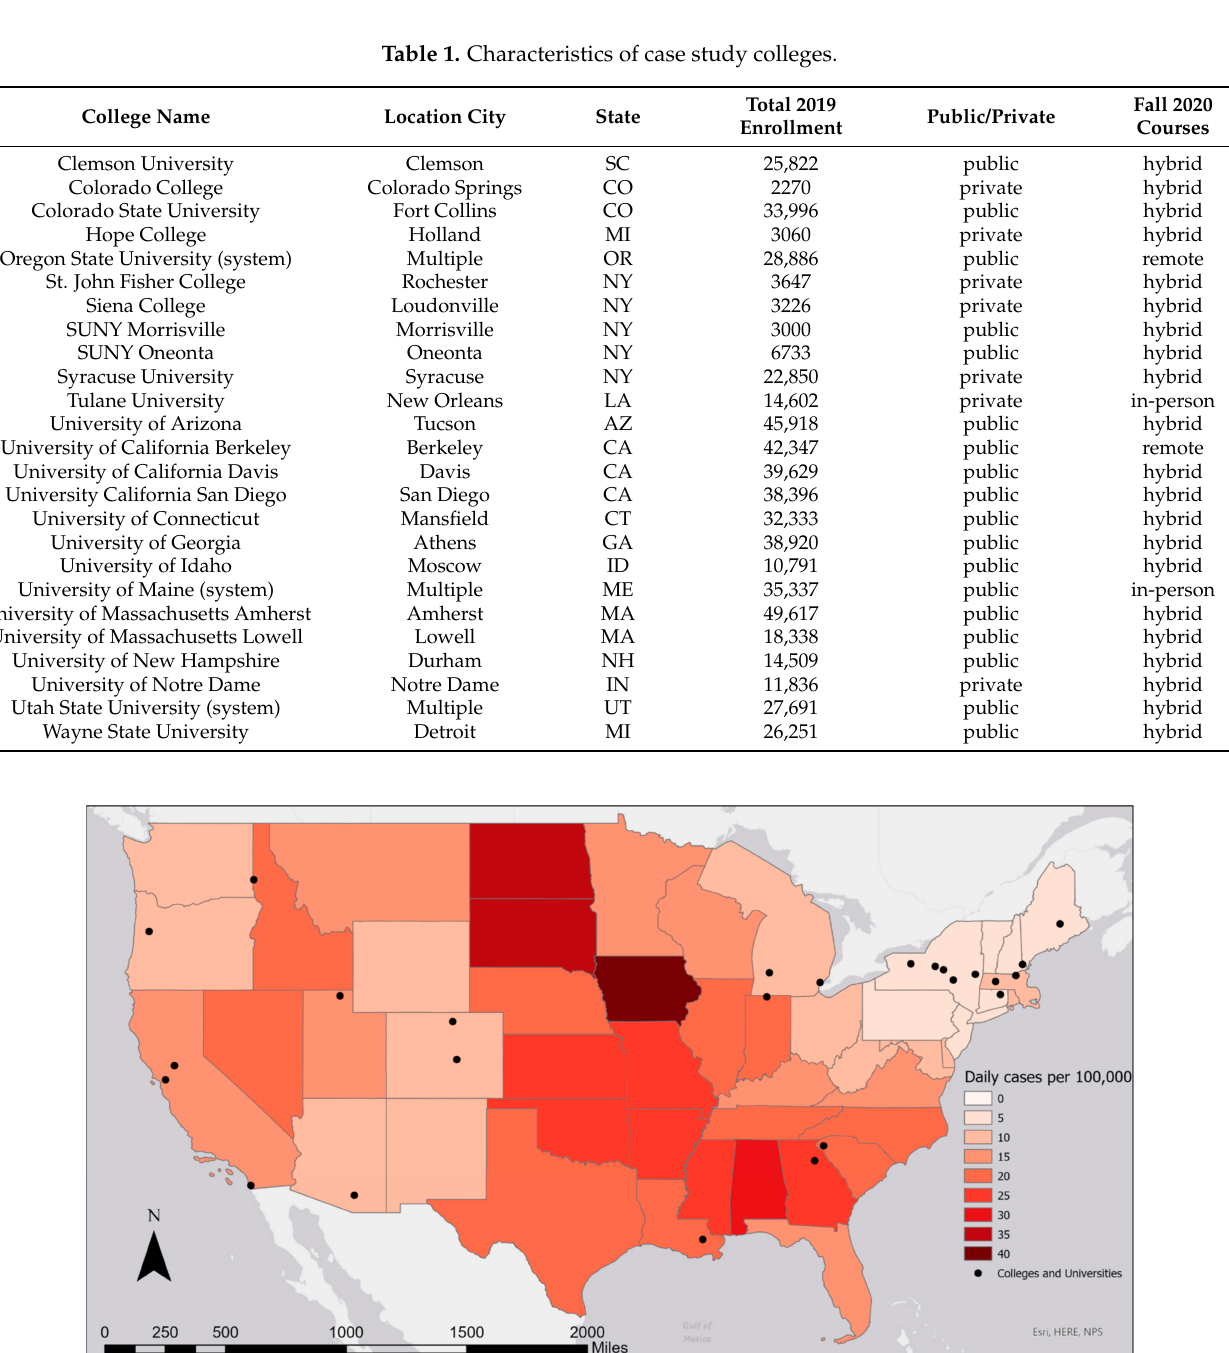
Figure 1. Map showing location of case study colleges and average daily number of COVID-19 cases per 100,000 population during the last week of August 2020, by state. Data from Centers for Disease Control and Prevention, 2020 [40]. Note: A single dot in Utah, Oregon, and Maine represents a system of more than one university in each state that work together on wastewater